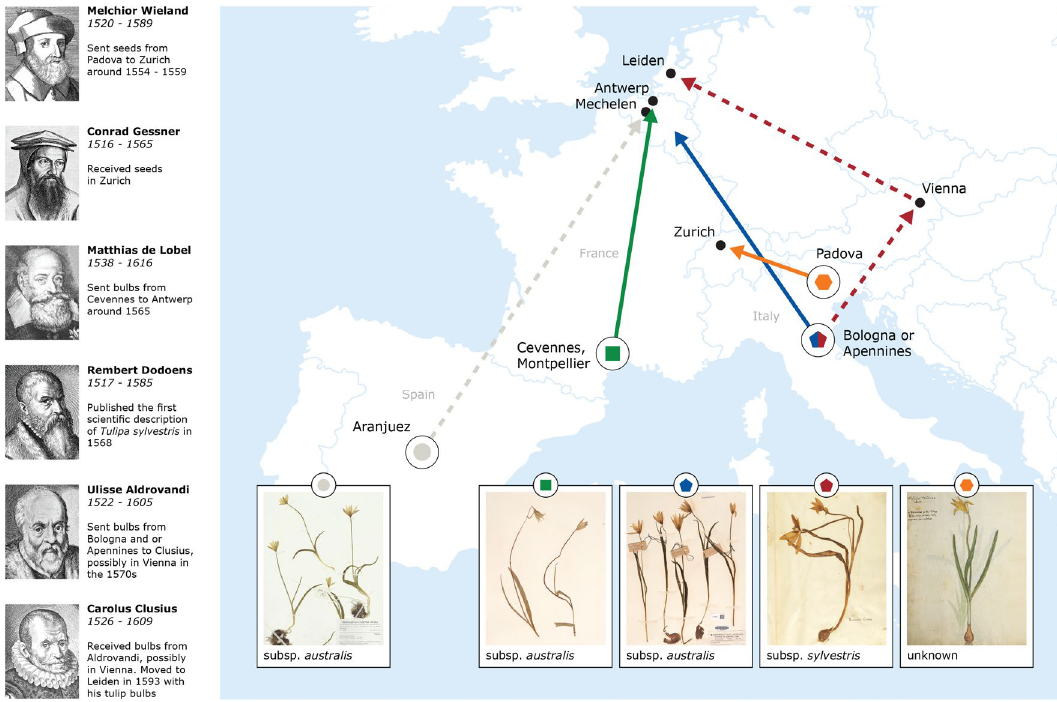
Figure 9. Illustrated history of introduction of Tulipa sylvestris in sixteenth-century Europe . Unlike the progenitors of modern tulip cultivars that came from the Ottoman empire (present day Turkey), the “wild tulip” ( T. sylvestris ) came from Italy and France, following the routes shown in this map. Plants from Spain were also introduced but apparently unsuccessfully (light grey). The depicted specimens (Naturalis Biodiversity Center), reflect the morphological diversity of the introduced plants: the French and Italian specimens are plants that have been collected in the Cevennes (L.1458540), Bologna (L.2110826) and the Apennines (L.1458536). The Spanish specimen (WAG.1057471) shows the presumed morphology of the plants introduced from Aranjuez. Infographic created by Alfred Heikamp with Adobe InDesign 2022 17.0 and Adobe Illustrator 2022 26.0.3. Background map: Shutterstock, https:// www. shutt ersto ck.